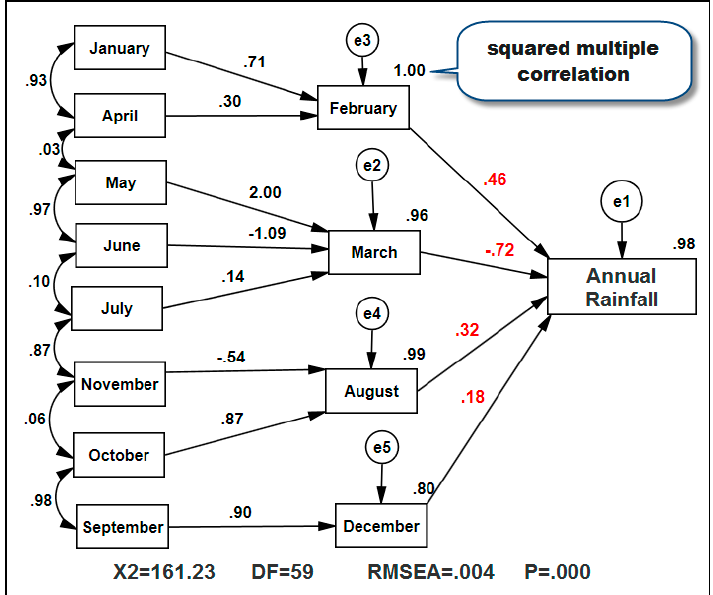
Figure 13. The effectiveness between the monthly temperatures and annual rainfall (first model).